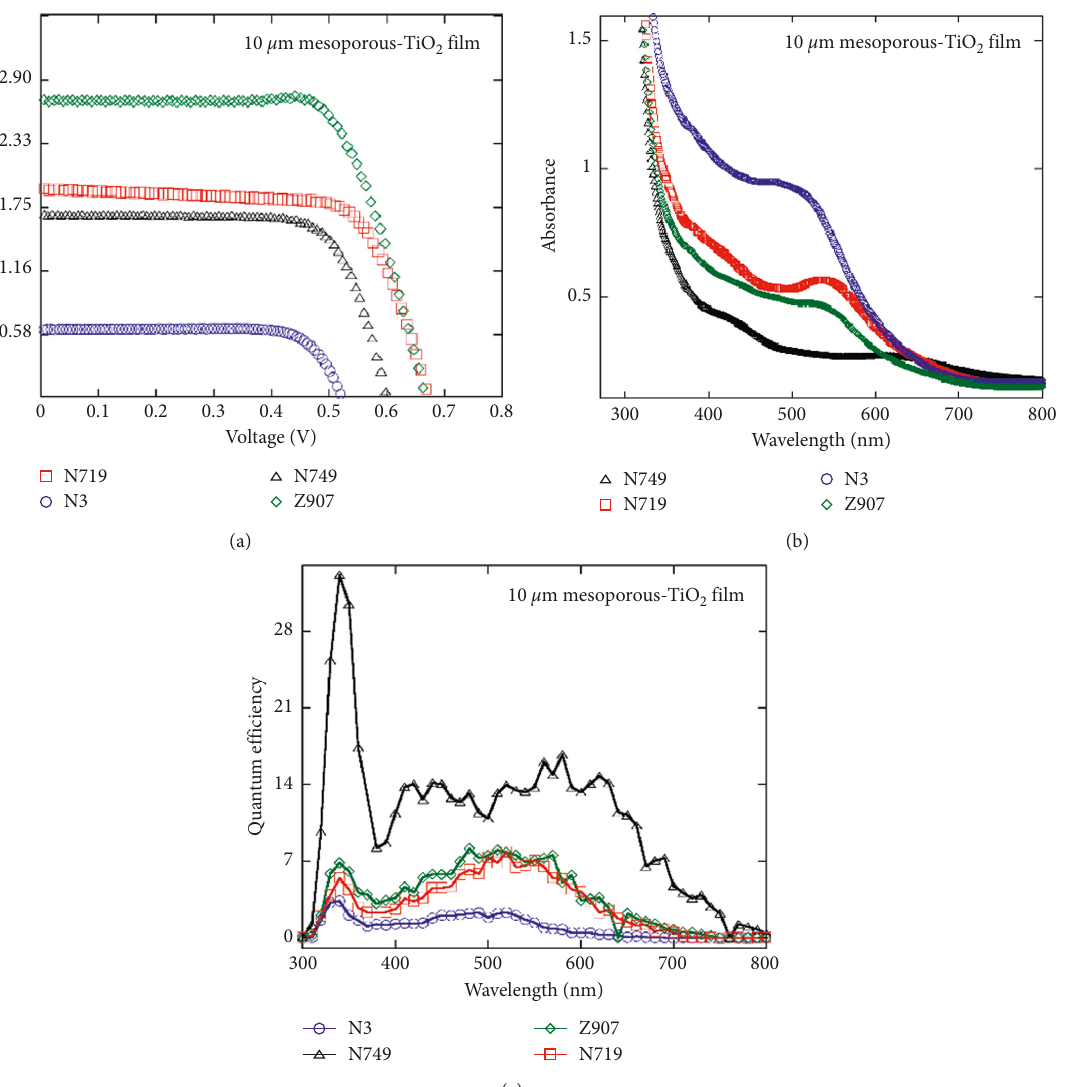
Figure 3: (a) IV and (b) quantum efficiency characteristic curves of devices fabricated with 10 μ m mesoporous TiO ruthenium dyes N3, N749, Z907, and N719. (c) Absorbance of dyes on solid 10 μ m mesoporous TiO 2 films shows inverse correlation with device quantum efficiency of respective dyes.